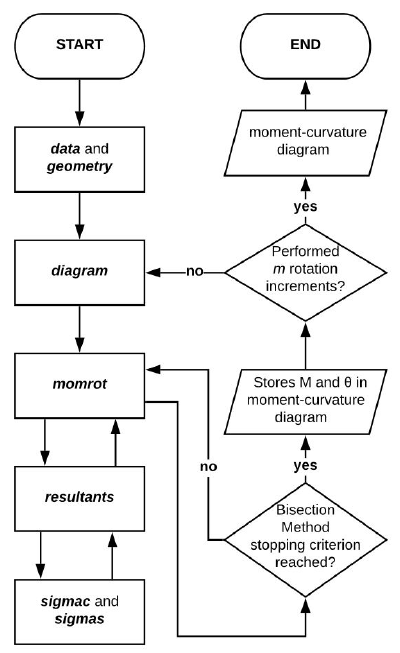
Figure 16. Moment-Curvature routines